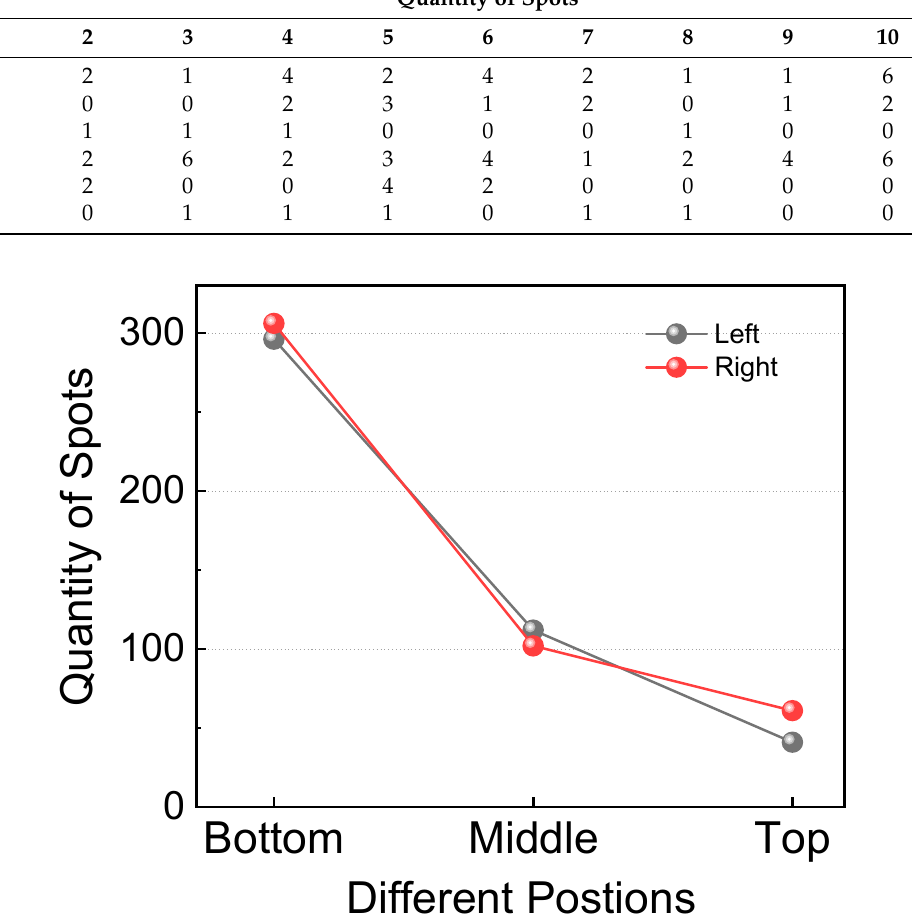
Figure 10. The relationship between the quantity and position of black spots.